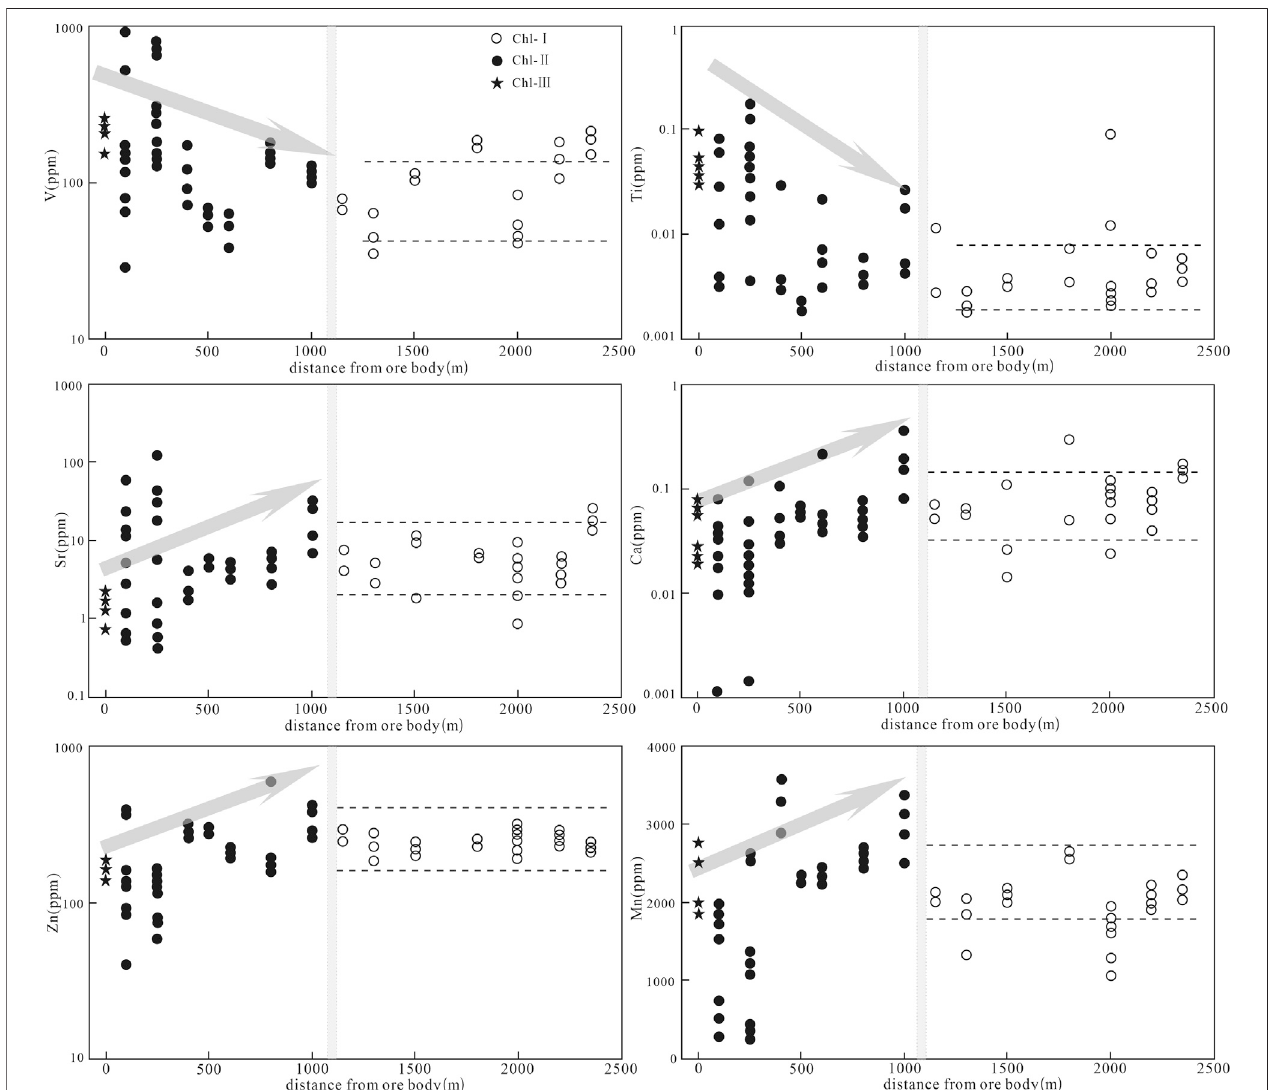
FIGURE 12 | Trace element spatial variations in chlorite for different alteration zones of the Tuwu porphyry Cu deposit in eastern Tianshan, Xinjiang, NW China.